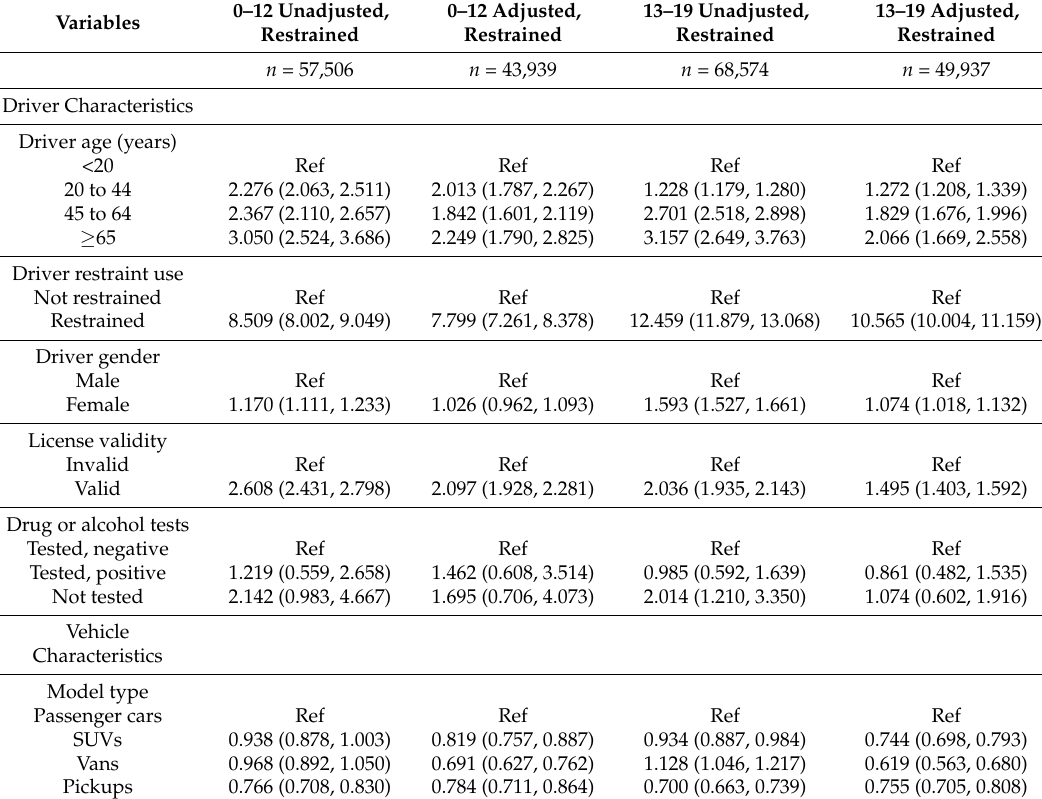
Table 4. Unadjusted and adjusted ORs (95% CIs) for infant, child and teen restraint status on non-Indian lands in the states with federally recognized Indian lands, FARS 2000–2014, categorized by passenger ages 0–12 and 13–19